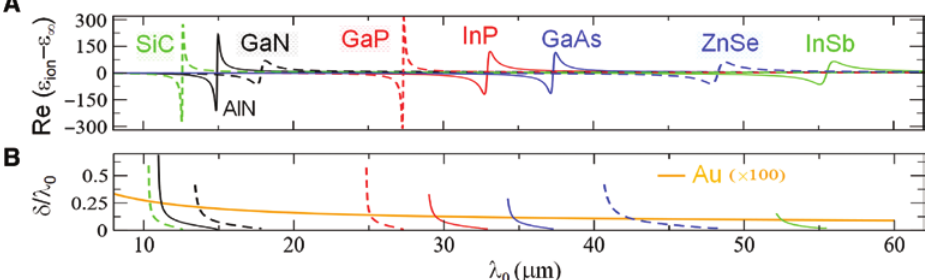
– ε ), versus the free-space wavelength, ∞ ion (shown only within the respective reststrahlen bands with 0